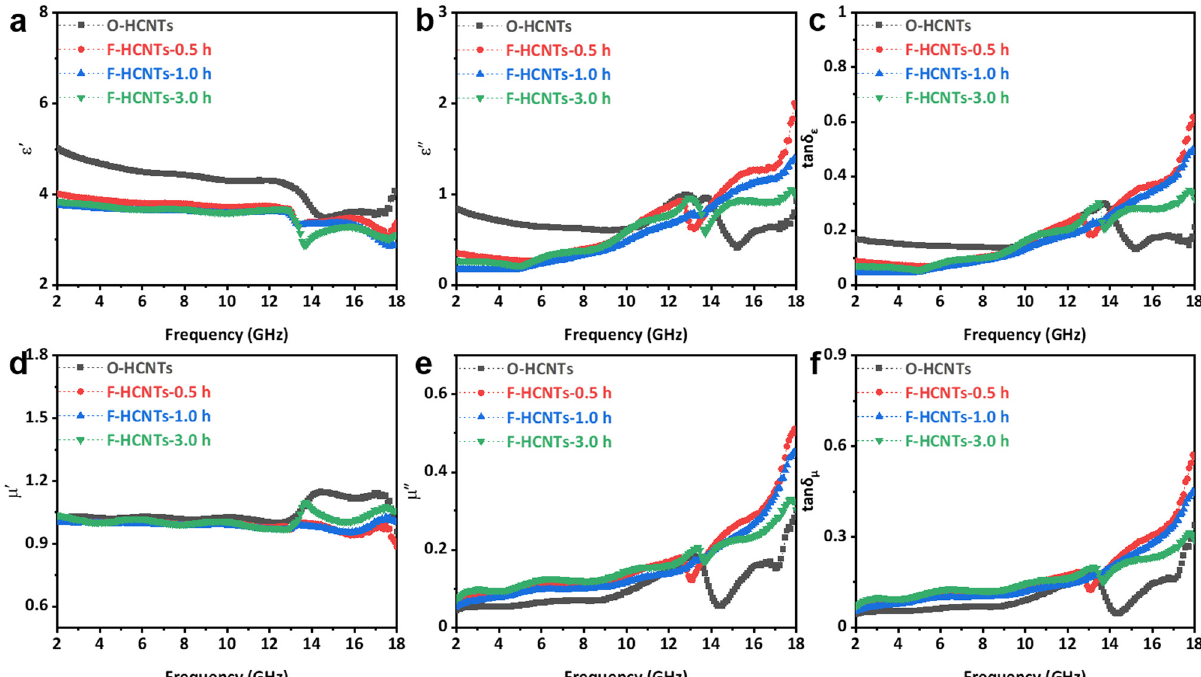
Figure 3: Measured frequency dependence of ( a ) ε ′ , ( b ) ε ″ , ( c ) tan δ ε , ( d ) μ ′ , ( e ) μ ″ , and ( f ) tan δ μ of O - HCNTs and F -